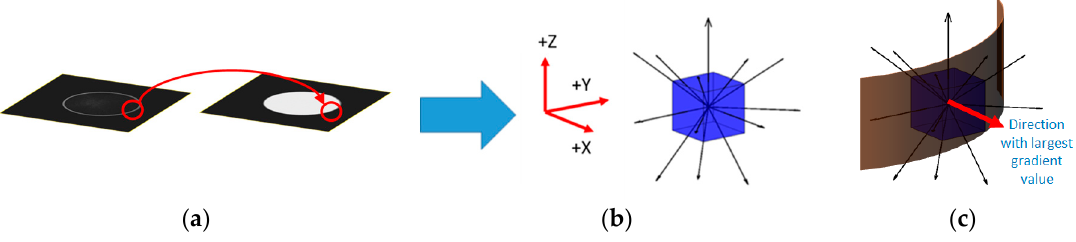
Figure 2. Sub-voxel refinement process: ( a ) Local maximum position detected, ( b ) calculation of the gradient along 13 directions, and ( c ) normal surface obtained from the largest gradient value direction to calculate the center of gravity.